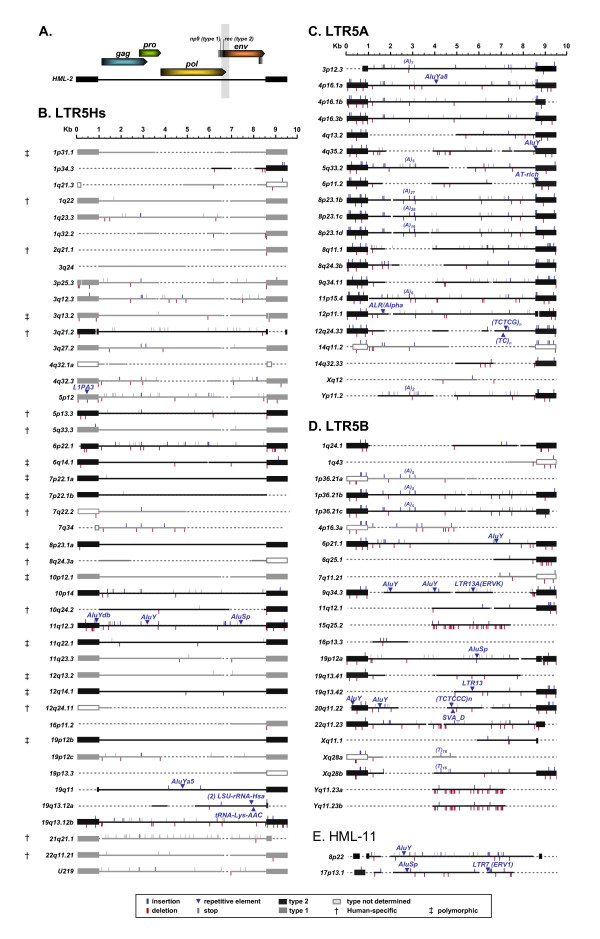
Cartoon schematic of HML-2 proviruses in the human genome. (A) A cartoon depicting the layout of the prototypical HML-2 retrovirus, including gag, pro, pol, and env gene positions. Splice sites of env, np9, and rec genes are also shown, with a faint gray band indicating the type 1 deletion region. Proviruses of the LTR5Hs (B), LTR5A (C), and LTR5B (D) groups are depicted and color-coded according to type. Type 1 proviruses colored in grey (with LTRs filled grey), type 2 colored in black (with LTRs filled black), and unclassified having open LTRs colored grey. Insertions and deletions < 3 bases are depicted with blue and red flags respectively. Larger insertions of retroelements are labeled according to type of element inserted, and large deletions are shown with dashed lines corresponding to missing sequence. Stop codons are indicated with a grey flag. Daggers indicate human-specific proviruses, with double daggers indicating polymorphic proviruses.